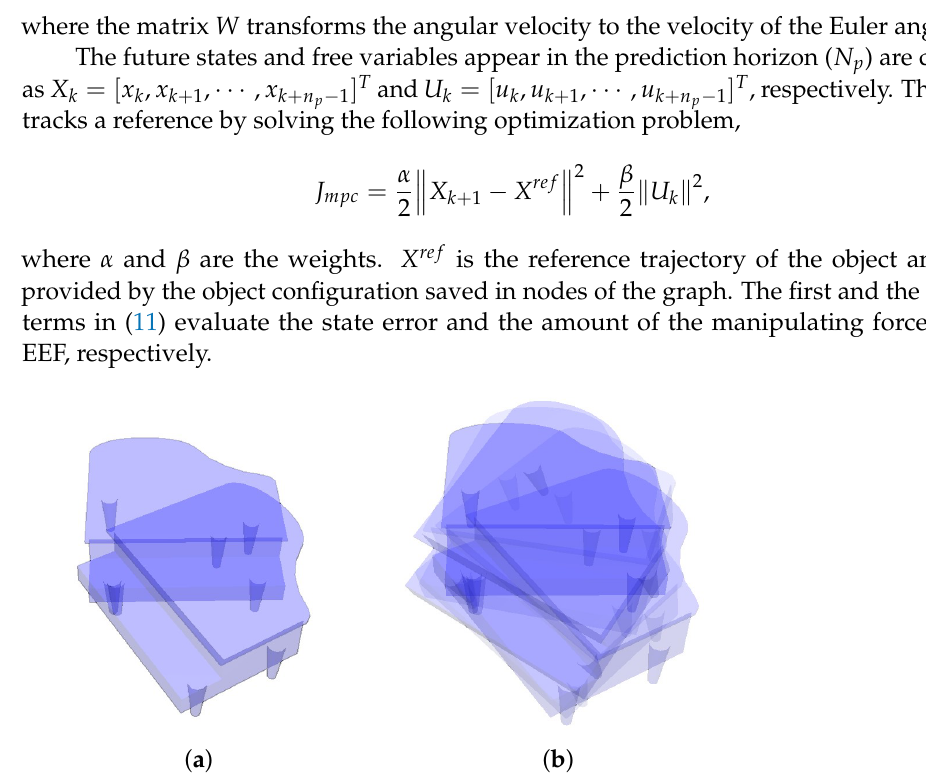
Figure 12. Example of pivoting motion to move a piano. ( a ) Two poses of the piano. ( b ) Transforma- tion of the object poses shown in ( a ) through pivoting motion. The object is tilted, rotated around one vertex, and then placed